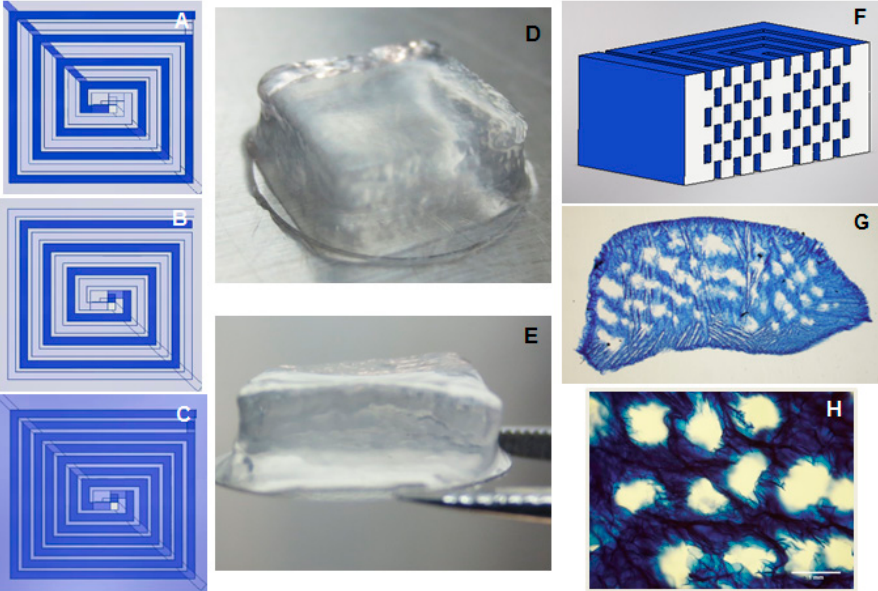
Figure 1. Three-dimensional printed Si-HPMC constructs with microchannels. ( A ) Design of the first of the odd layers of the construct, where darker line represents gelatin printed strands, and lighter lines represent Si-HPMC strands. ( B ) Design of even layers of the construct. ( C ) Representation of the top view of the construct morphology of the 3D bioprinted construct of cell-laden Si-HPMC. Printed constructs with microchannels ( D ) before and ( E ) after gelatin removal (9 × 9 × 4 mm). ( F ) Representation of a cross section of the channeled construct (without bottom and top Si-HPMC-only layers). ( G ) Optical image of the transversal slice of the stained construct exhibiting microchannels after gelatin removal. ( H ) A zoomed-in part of the transversal slice. Si-HPMC: silanized